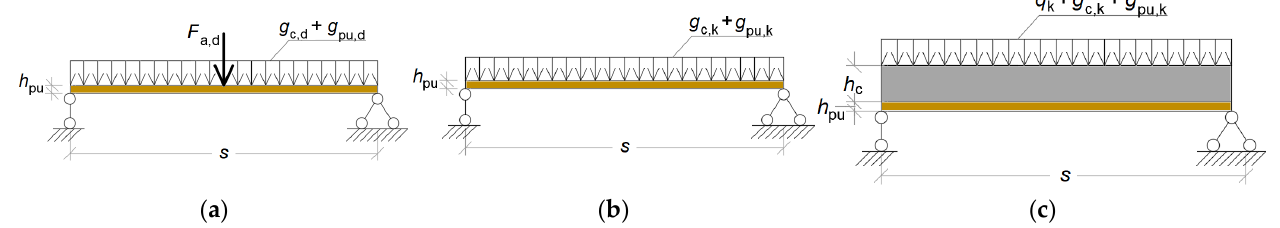
Figure 8. Design schemes for: ( a ) the load-bearing capacity of the upper plywood layer per 80 kg assembly load F a,d and self-weight from concrete g c,d and plywood layers g pu,d ; ( b ) the deflection of the upper plywood layer from the self-weight of concrete g c,k and plywood layers g pu,k ; ( c ) the deflection of the concrete and top plywood layers from the self-weight of both layers and the useful uniformly distributed load q k , where s is the rib step; h c and h pu are thicknesses of concrete and upper plywood layers.